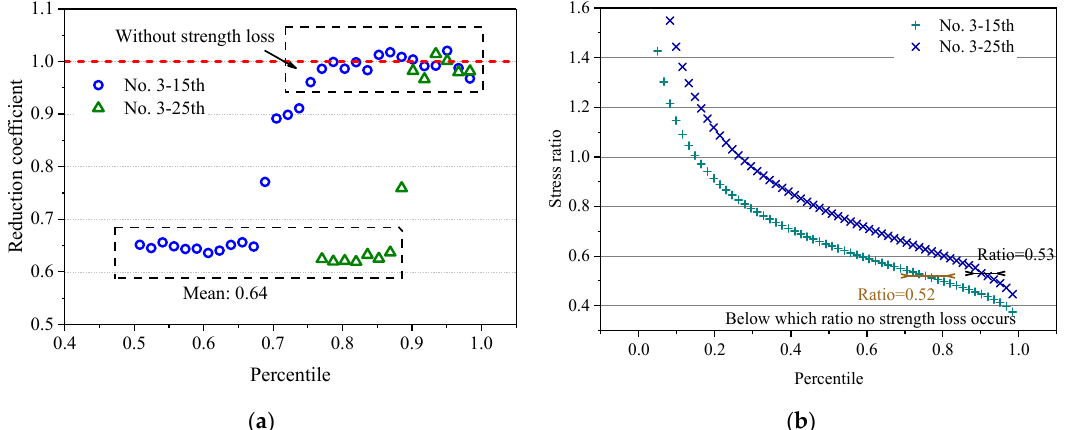
Figure 8. Test results of Grade No. 3 dimension lumber. ( a ) Strength reduction coefficient of the survivals, ( b ) Stress ratios of all specimens.